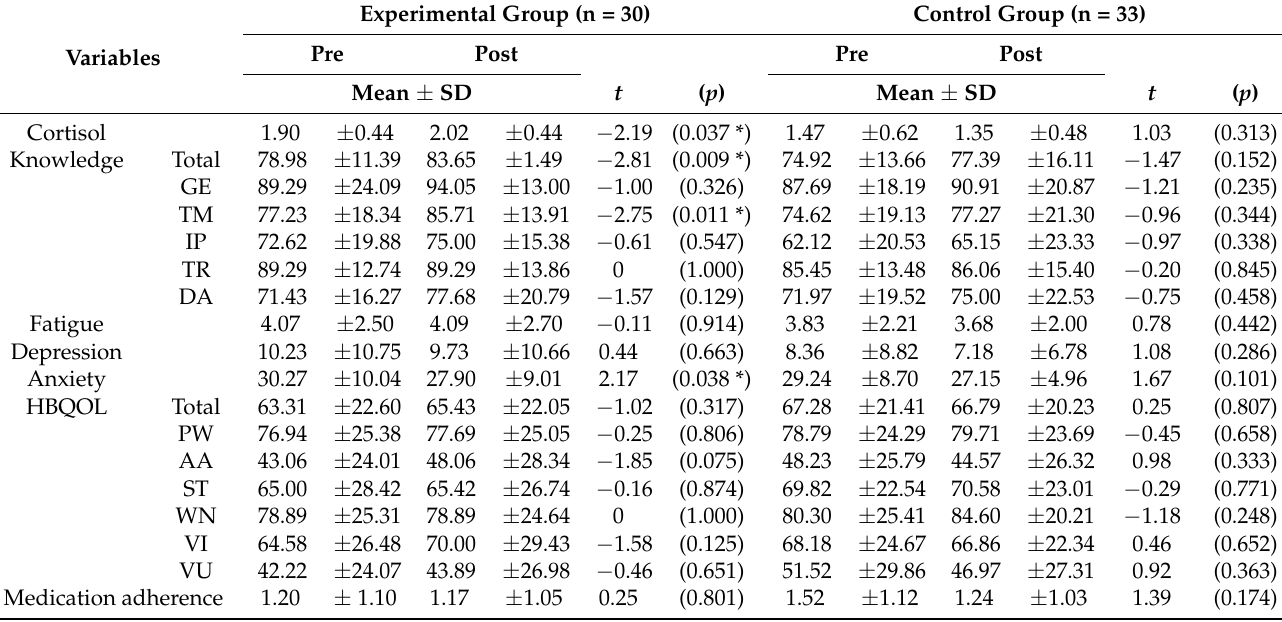
Table 2. Comparison of outcomes of groups in a 12-week pilot test of a smart app intervention for HBV management. N = 63.